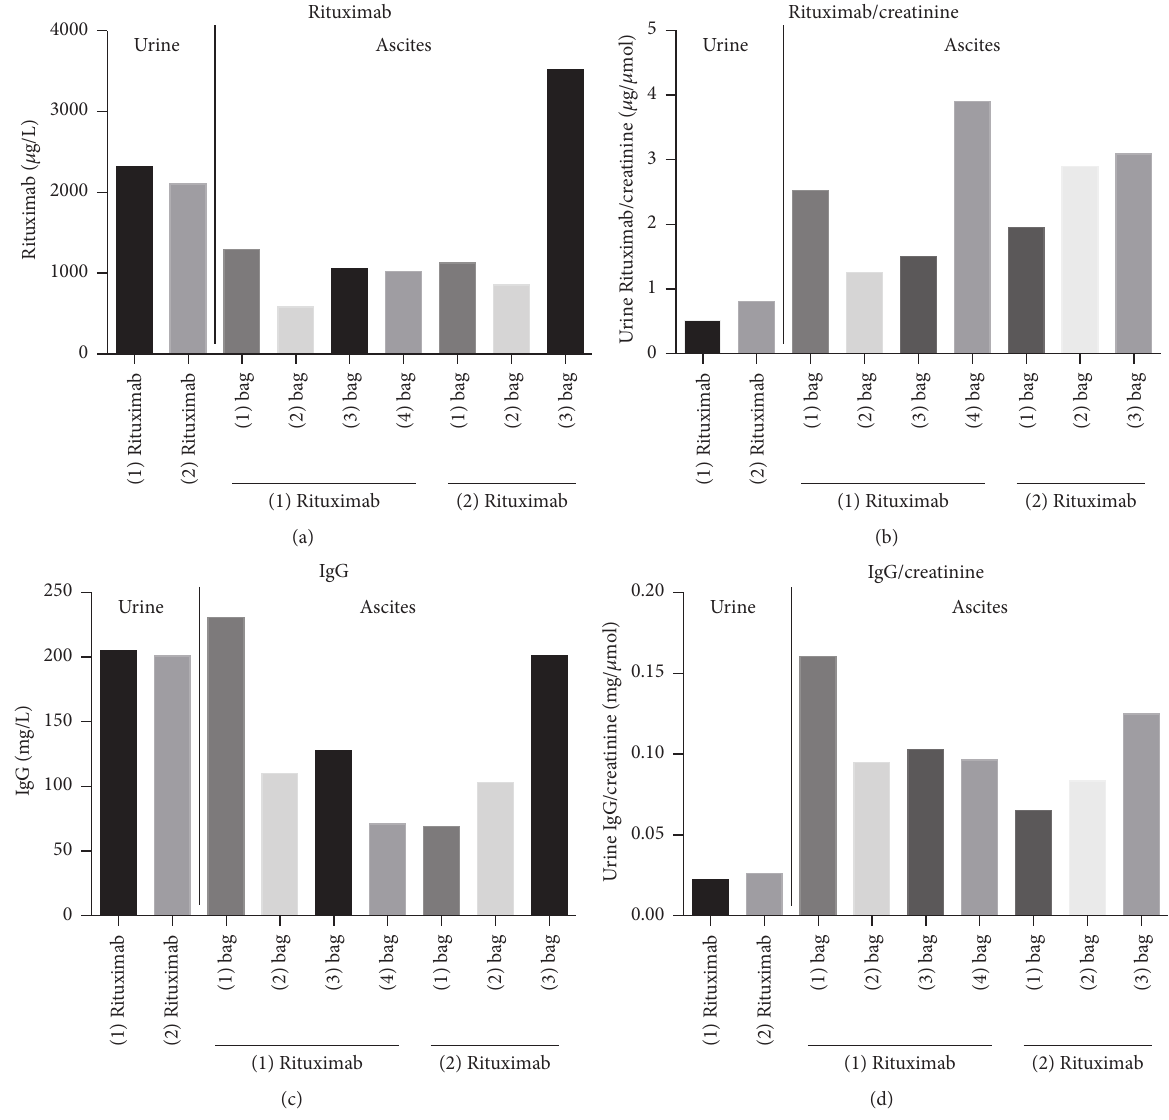
Figure 4: Rituximab urine and peritoneal fluid Rituximab concentrations (a) and Rituximab/creatinine ratios (b), as well as IgG urine and peritoneal fluid concentrations (c), and IgG/creatinine ratios (d) of the second case. Since the second patient performed CAPD with three to four peritoneal fluid bag changes per day, the corresponding effluent bags are numbered in chronological order.